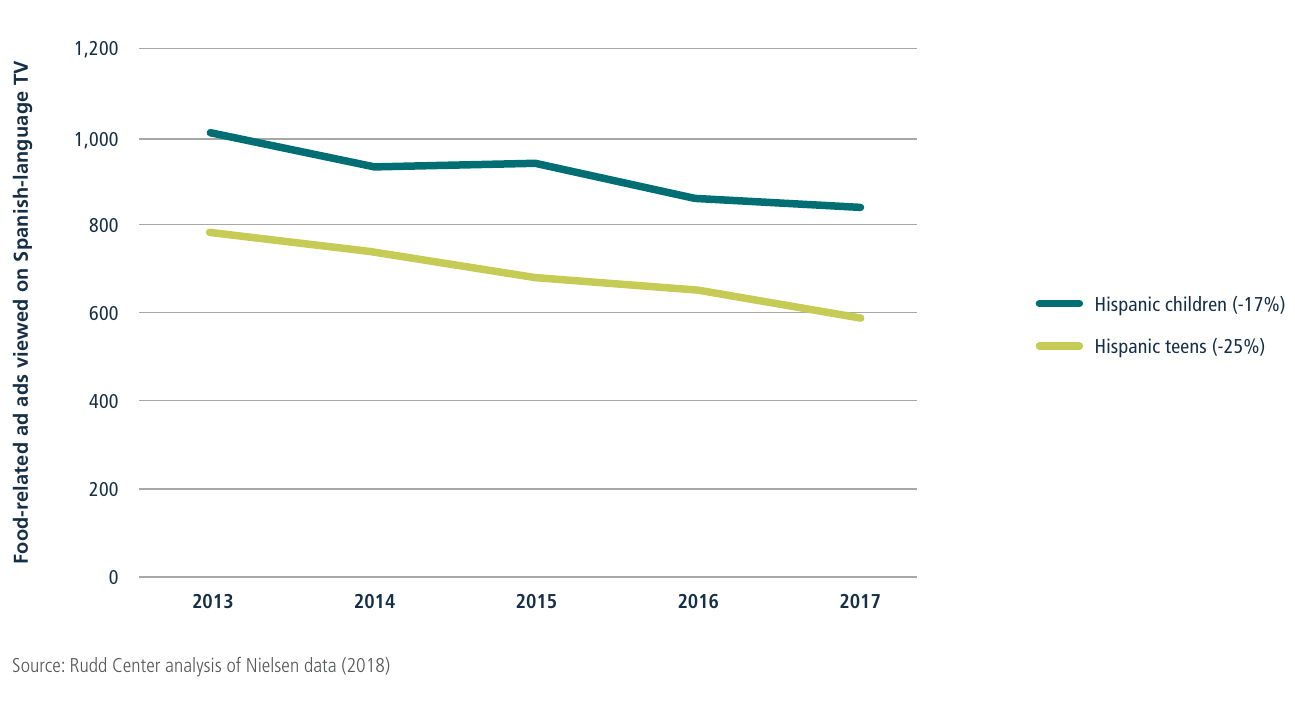
FIGURE 3. CHANGES IN FOOD-RELATED AD EXPOSURE ON SPANISH-LANGUAGE TV BY HISPANIC CHILDREN AND TEENS